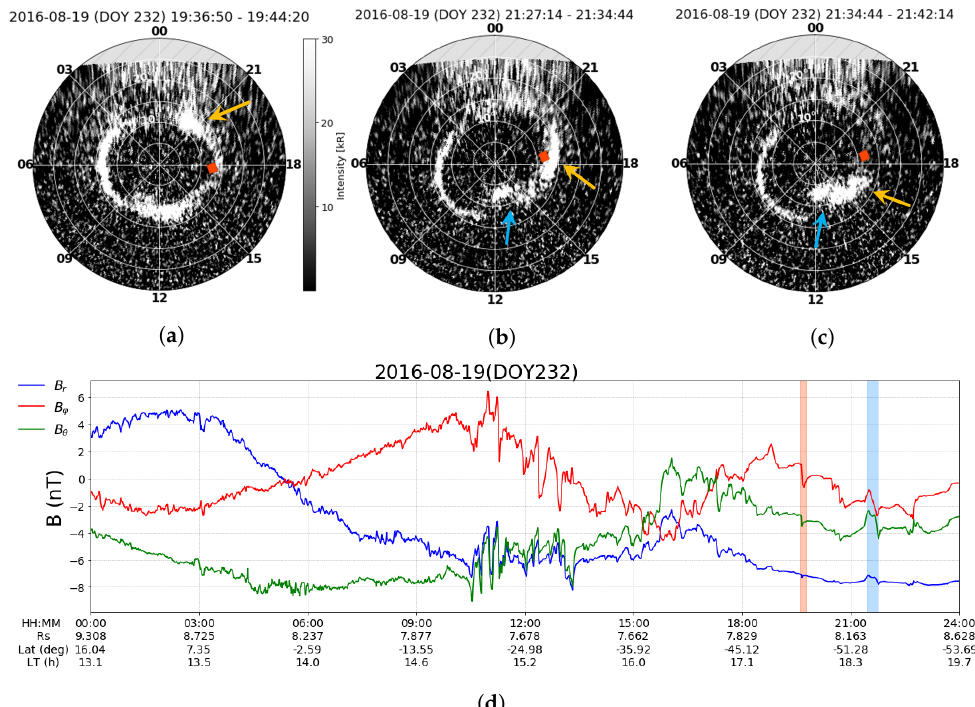
Figure 4. ( a – c ): HST images of Saturn’s northern hemisphere in polar projection for two separate events on 2016-232, event no.21 ( a ) and event no.22 ( b , c ). The yellow arrows highlight the identified transient feature, and the blue arrows highlight a rather persisting feature at high latitudes in the 12-15 LT sector. The polar projection is the same as Figure 1, and the integration time of the images is 450 s. All three panels share the same colour bar as panel ( a ) represnting the auroral intensity in kiloRayleigh (kR). ( d ): 24-h in-situ magnetic field measurement in KRTP coordinates by Cassini magnetometer. The orange shading represents the time when the transient flashes were observed by the HST as shown in panel ( a ), and blue represents the flash shown in ( b , c